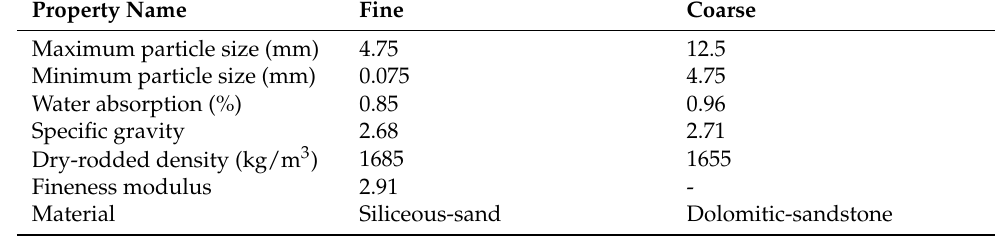
Table 2. Properties of aggregates.